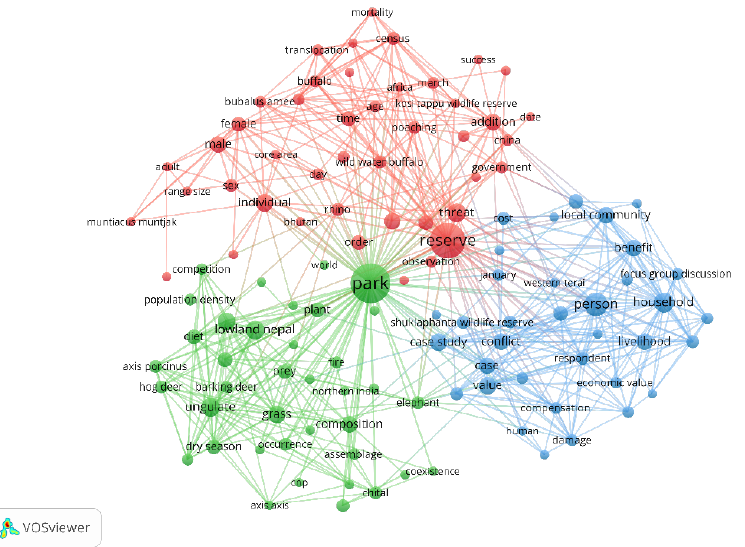
Figure 13. Mapping of “Wildlife Reserves”.